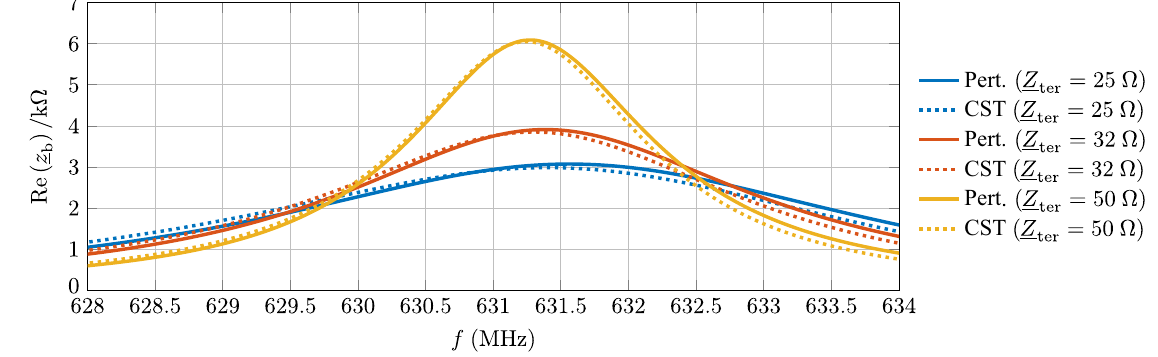
FIG. 3. Real part of the beam coupling impedance of the four-cell SPS TW structure shown in Fig. 2. The blue curves refer to a termination impedance Z of 25 Ω , the red curve to 32 Ω , and the orange curve to 50 Ω . The dotted curves are obtained with the ter wakefield solver of CST S tudio S uite ® , whereas the solid curves are obtained by generalized scattering matrix concatenation CSC BEAM and the approach proposed in this paper for the coupler port